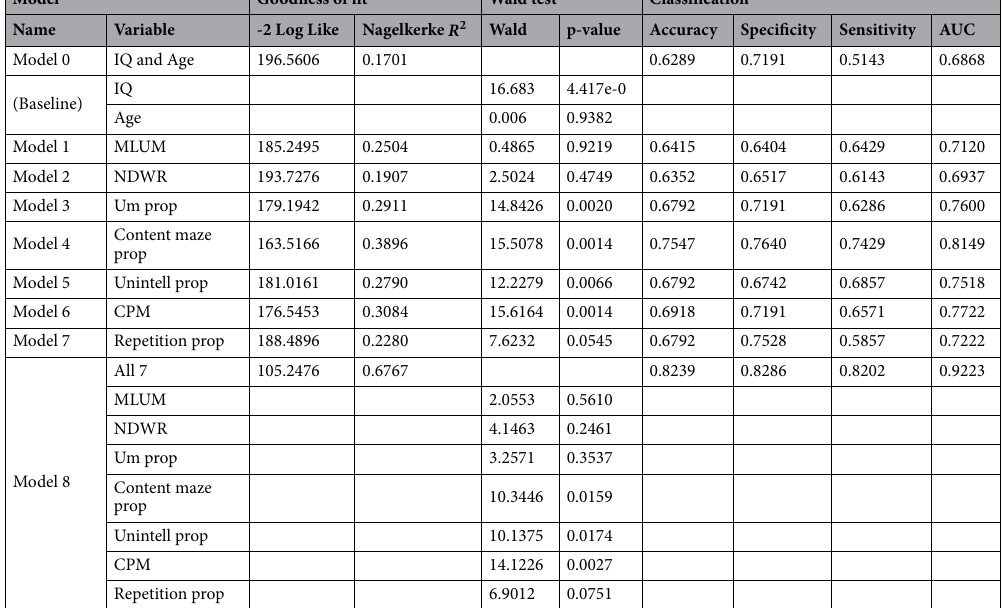
Table 5. Logistic regression models for ALMs adjusted by age and IQ. Model 0 uses only IQ and age. Models 1-7 use a single ordinal recoded ALM, and include IQ and age. Model 8 uses all seven recoded ALMs, and includes IQ and age. -2 Log Like is the -2 times the log-likelihood of the model (low values reflect better fit). Nagelkerke R 2 is a pseudo- R 2 measure (high values reflect better fit). Wald is the Wald test statistic chi-squared value and p-value is the p-value of the Wald result for the listed variable. The degrees of freedom for the Wald test were 1 for IQ and age and 3 for all other variables. Accuracy, specificity (true negative rate), sensitivity (true positive rate), and AUC are classification results for predicting ASD